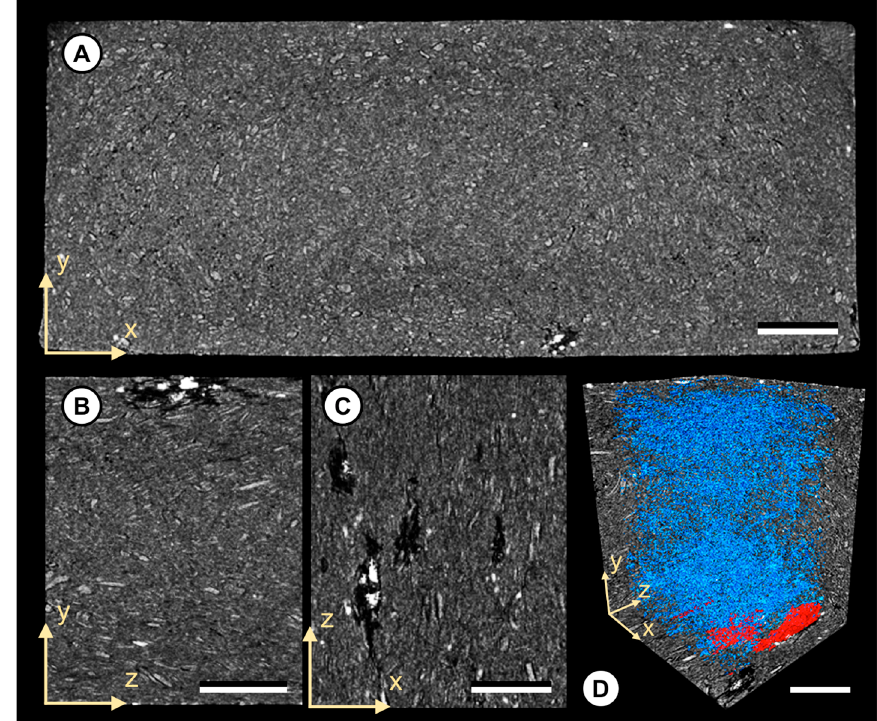
Figure 2. Tomographic images of WPC C100 1 exposed to the white rot fungus Trametes versicolor . ( A ) The yx-plane view displaying the entire cross-section of the sample. Note the visible particle/matrix delamination patterns and large air pockets close to the composite surface. ( B,C ) Detailed view of the air pockets close to the composite surface (yz-plane and zx-plane). Note the high absorbing particulates (white) within the pocket cavity. ( D ) Detailed view of the spatial void distribution throughout the sample. Note the separated air pockets marked in red. Scale bar: 1000 μ M.